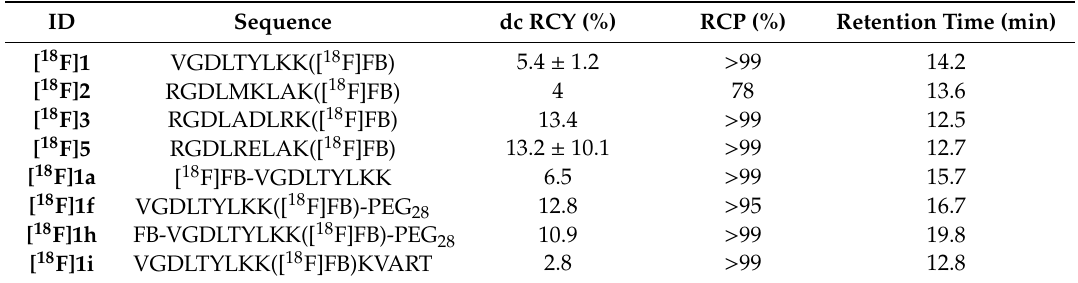
Table 3. Analytical data of all 18 F-radiolabeled peptides evaluated in cell binding and serum stability